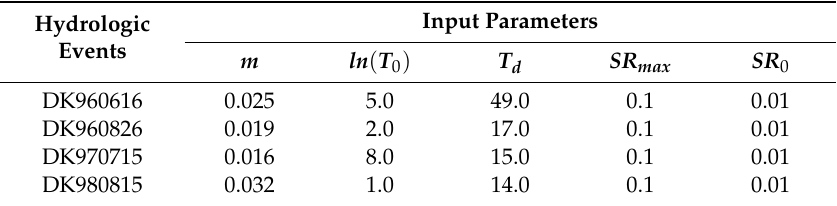
Figure 8. Rainfall–runoff events by applying a constant parameter set depending on different DEM resolution values in the Dongkok watershed. ( a ) 16 June 1996. ( b ) 26 August 1996. ( c ) 26 July 1997. ( d ) 15 August 1998. Table 4. Applied fixed input parameter sets in the Dongkok watershed.